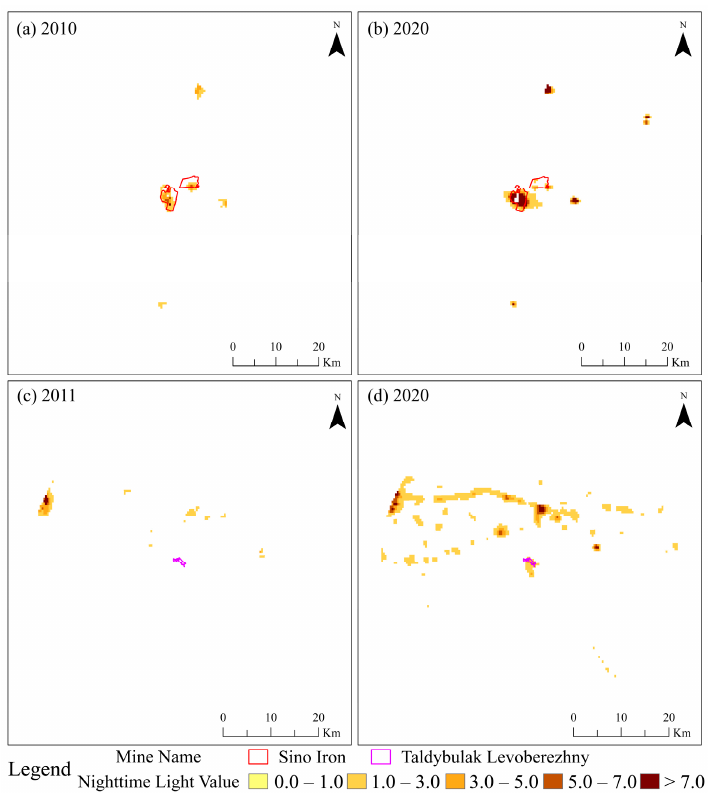
Figure 3. The nighttime light images of the monitoring area in different periods ( a , b ) for Sino Iron; ( c , d ) for Taldybulak Levoberezhny.